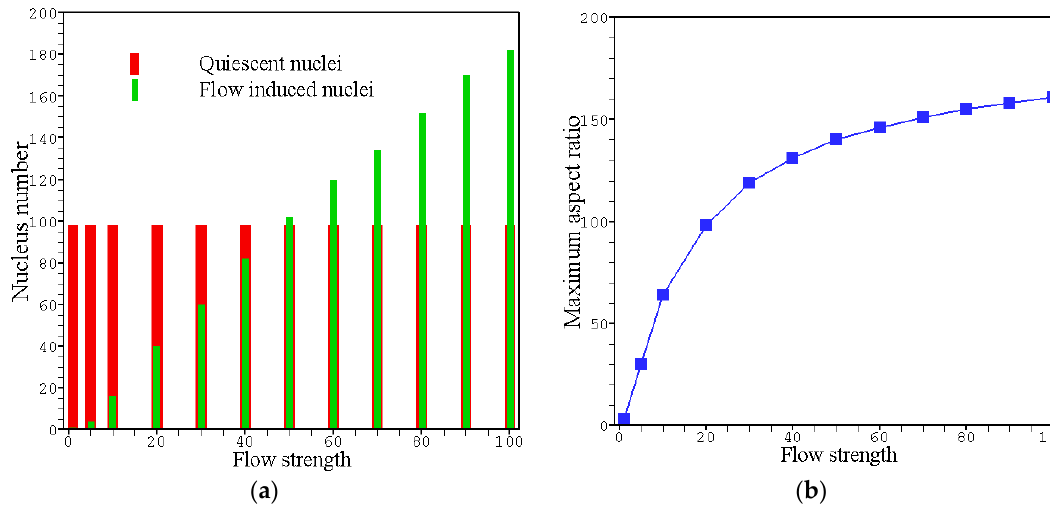
Figure 4. Flow effects on nucleus number and nucleus shape within the simulation region: ( a ) the variation of nucleus number (refer in particular to the flow induced part) with the dimensionless flow strength ˆ γ ; ( b ) plot of the maximum aspect ratio of the nuclei against the dimensionless flow strength ˆ γ .